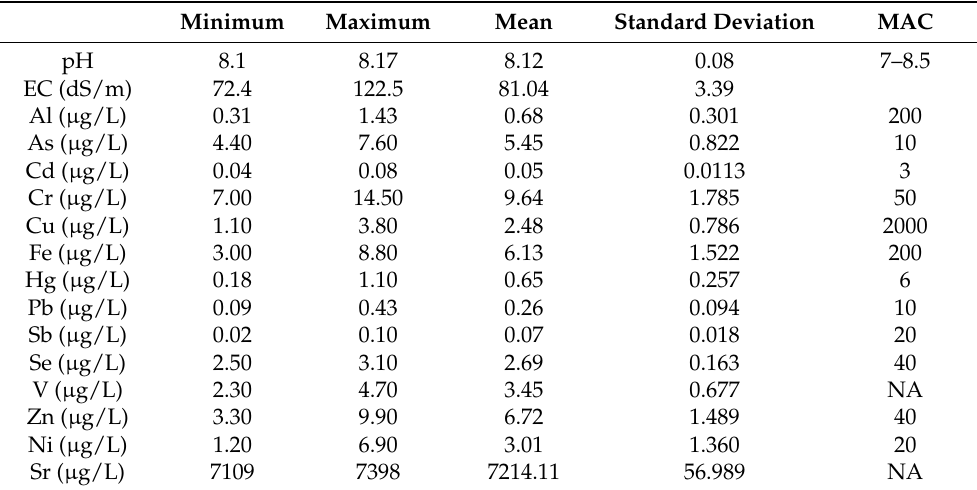
Table 2. Statistics of HMs measured in Al-Ugair surface seawater samples as compared to the maximal admissible concentration (MAC) of WHO